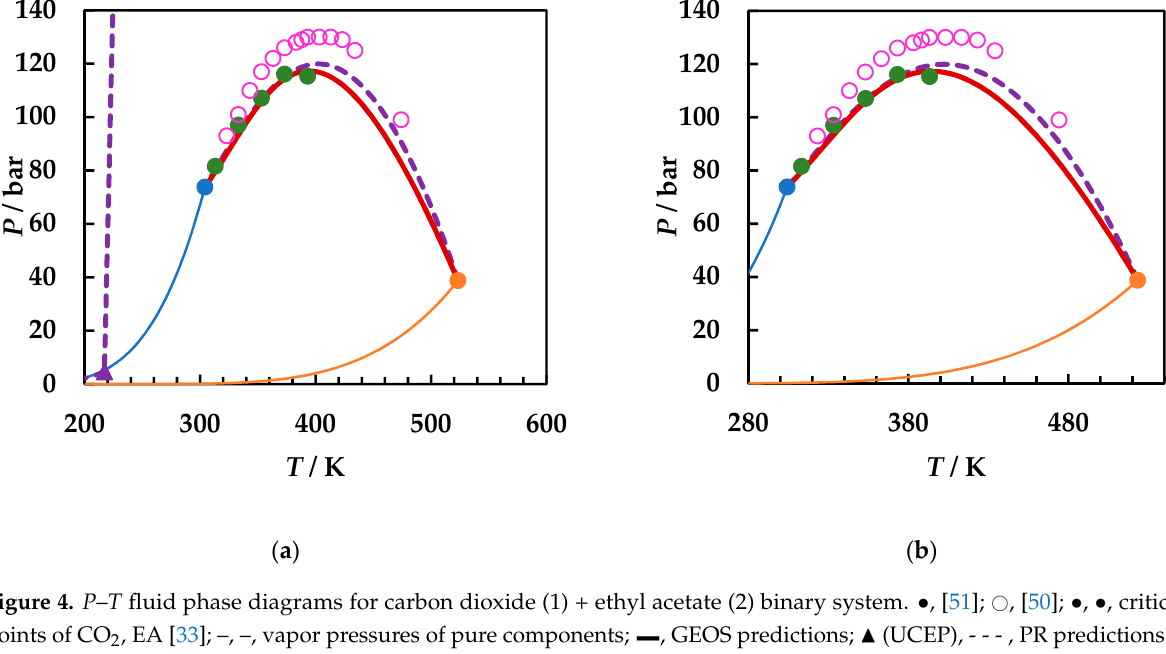
, [50]; • , • , critical (cid:35)